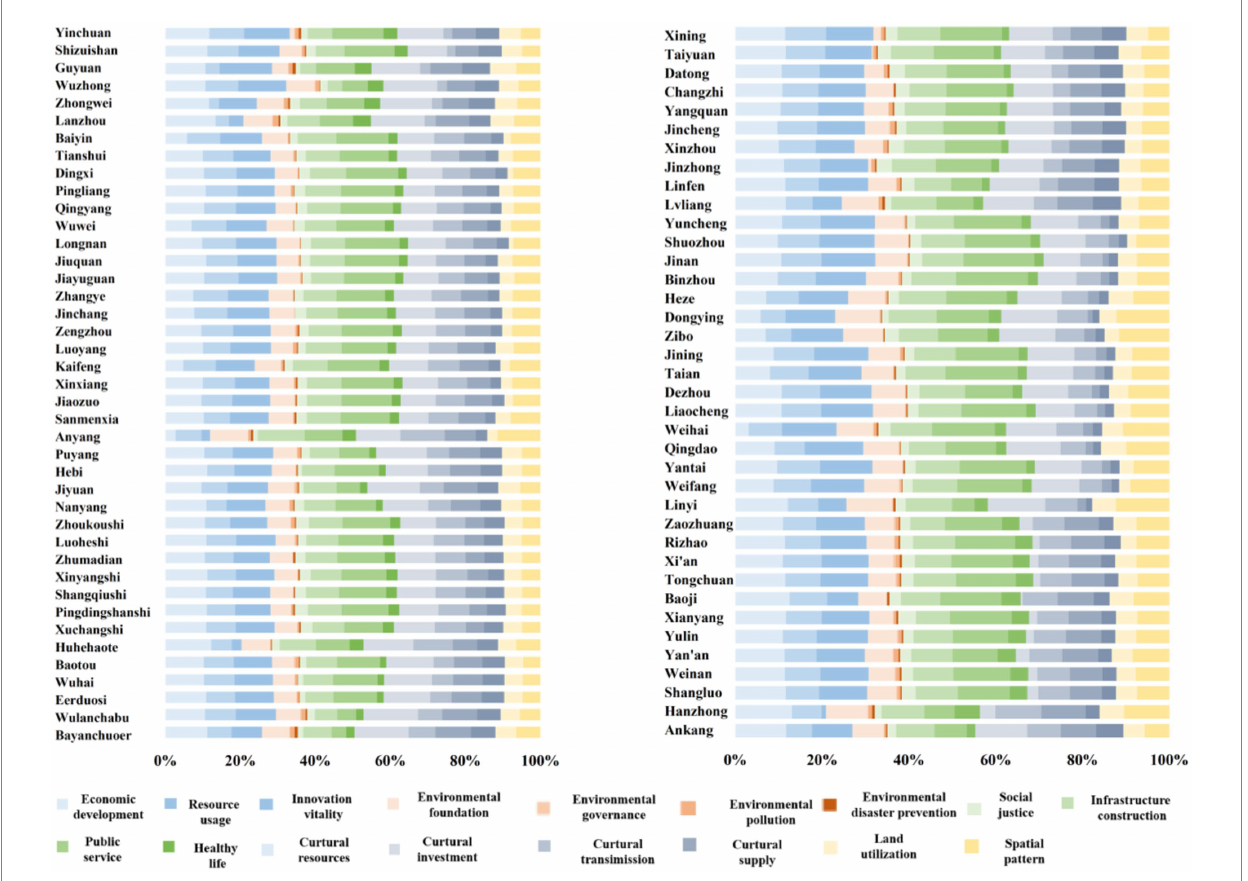
FIGURE 6 Obstacle degree of main obstacle factors in the index for assessing quality of urban ecological construction in the Yellow River basin, expressed as